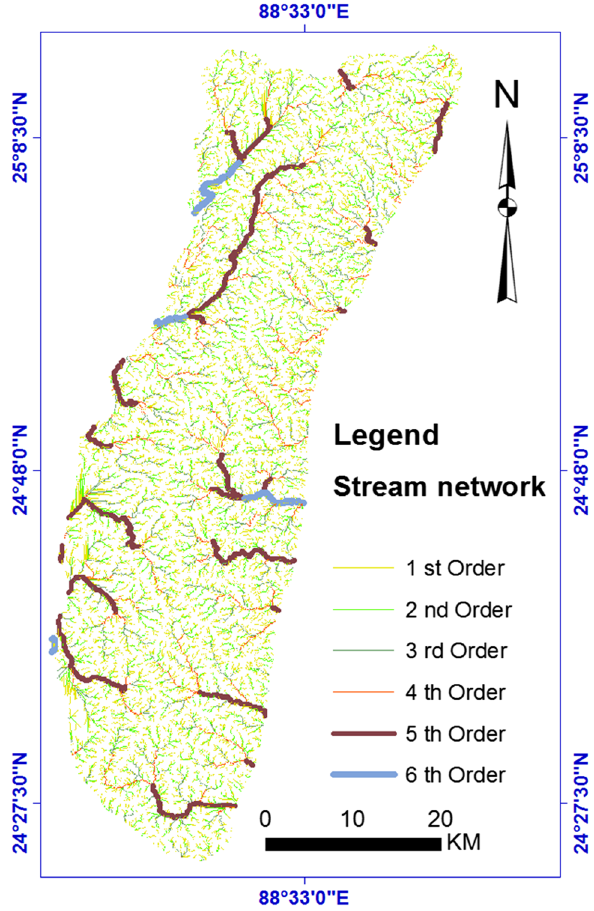
Fig. 7 Stream network of the proposed